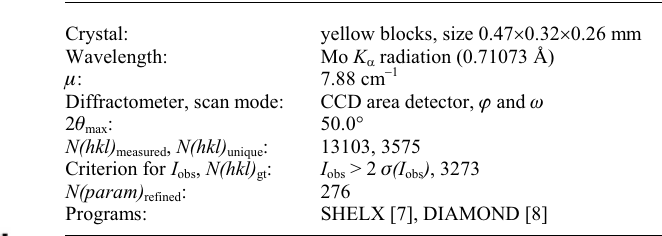
Table 1. Data collection and